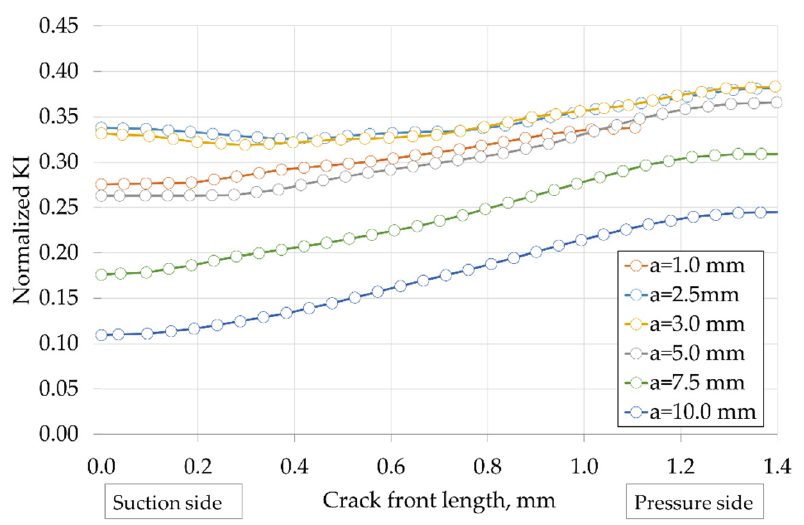
Figure 20. Evolution of K I along the crack front for a given crack length at the PETE—normalized with the material fracture toughness.